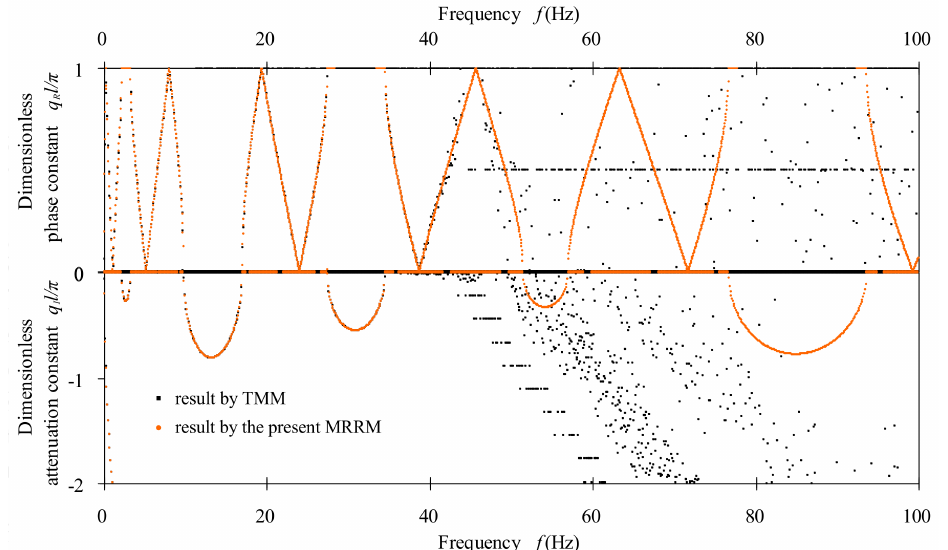
Figure 5. Comparison of the band structures obtained by MRRM and TMM for bi-coupled periodic beam consisting of three Binary-IIs as the super cell. (MRRM: Method of reverberation-ray matrix; TMM: Transfer matrix